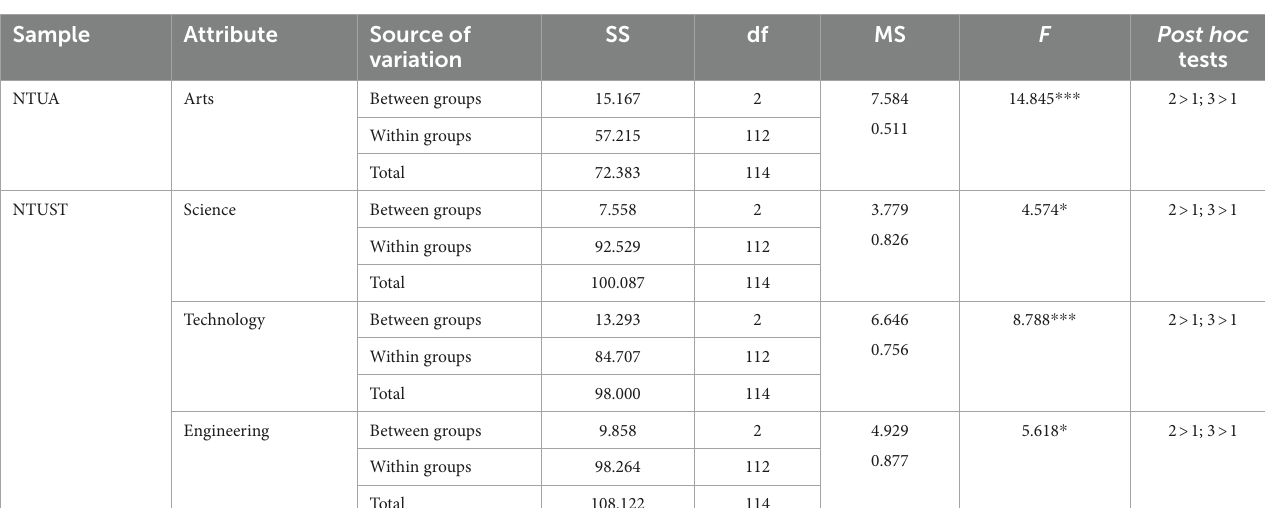
TABLE 8 A comparison of NTUA and NTUST assessments by subjects from